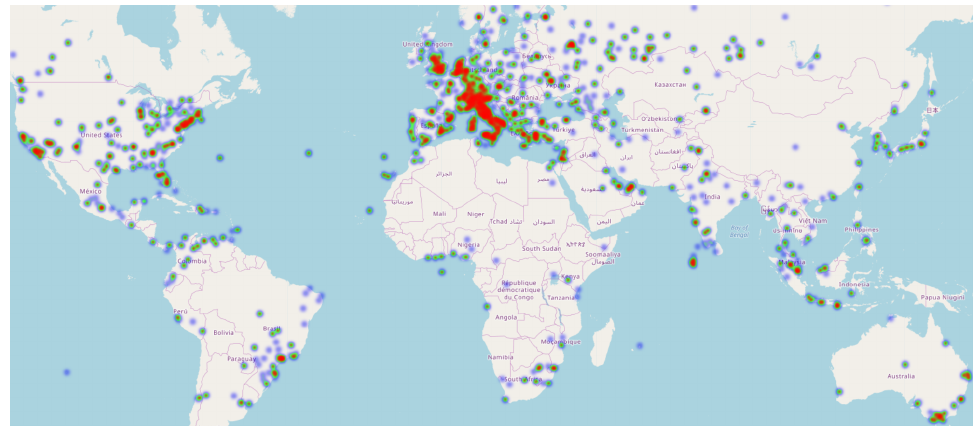
Figure 12. Geographical distribution of social media reaction to the Milan Fashion Week